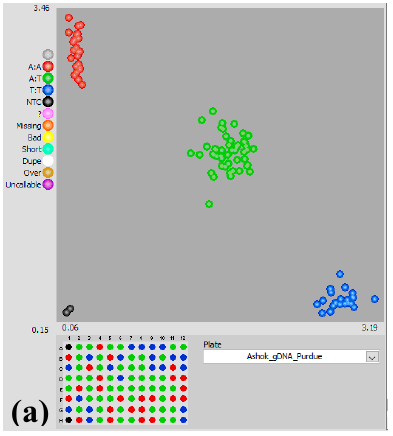
Figure 5. Snapshots showing single nucleotide polymorphism (SNP) genotyping in parental inbred line LM11, CML25, and their F 2 mapping populations with KASP marker assays. The snapshots show ( a ) polymorphic pattern, occurrence of allele specific to LM11 (blue spots) and CML25 (red spots), and heterozygosity for the corresponding alleles (green spots) in F 2 mapping population. ( b ) occurrence of only one allele (blue spots), and heterozygosity for corresponding allele (green spots). ( c ) monomorphic pattern, occurrence of allele specific to LM11 (blue spots). ( d ) monomorphic pattern, occurrence of allele specific to CML25 (red spots), and missing data (pink spot). ( e ) the majority of missing data (pink spots), and one allele (red spots), occurrence of failed amplification signals i.e., invalid markers, in all snapshots black spots represent no template controls (NTCs). 2.4. Impact Analysis and Functional Classification of SNPs In terms of the types of SNP shifts, transition (Ts) and transversion (Tv) have a larger effect on the regulation of gene expression. A transition is a point mutation, which converts a purine nucleotide into another purine (A ↔ G) or a pyrimidine nucleotide into another pyrimidine (C ↔ T). Transversion refers to a purine (A or G) being substituted for a pyrimidine (C or T), or vice versa. The Ts/Tv mutation ratios of SNPs produced from GATK were 1.62, 1.83, and 1.64, respectively,